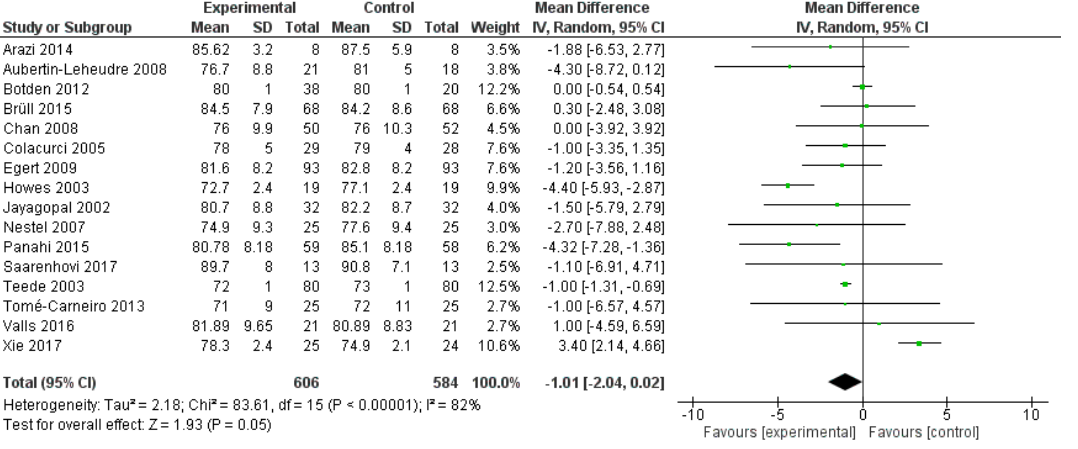
Figure 3. Pooled analysis of association between polyphenol intake and diastolic blood pressure. HDL-C was reported in 21 studies, for a total of 1933 patients (988 treated with polyphenols and 945 with placebo). The polyphenol administration significantly increased HDL-C serum levels (mean difference 2.68 mg/dL, 95% CI: 2.43, 2.92 mg/dL, p < 0.001) (Figure 4).